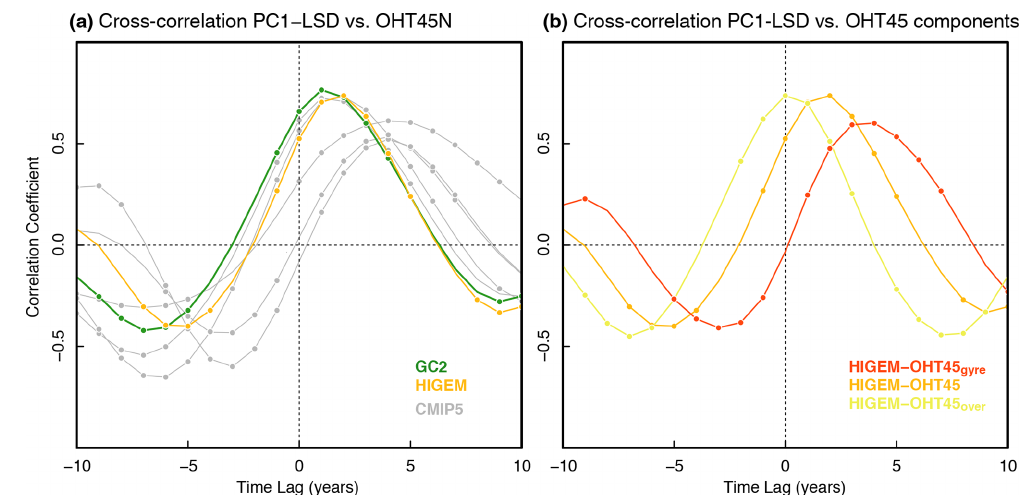
Figure 7. (a) Lead–lag correlations in a subset of the picontrol experiments between the PC1-LSD index and the ocean heat transport across the 45 ◦ N transect (OHT45N). Note that the ocean heat content is only available for five models of the CMIP5 ensemble. Correlations are based on 10-year running trends. (b) The same as in (a) but only in HiGEM for the different terms of the OHT45N. For positive lags, PC1-LSD